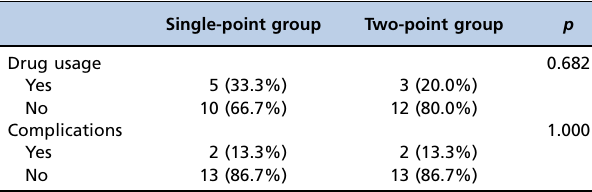
Table 5 - Results of drug usage and complications (number